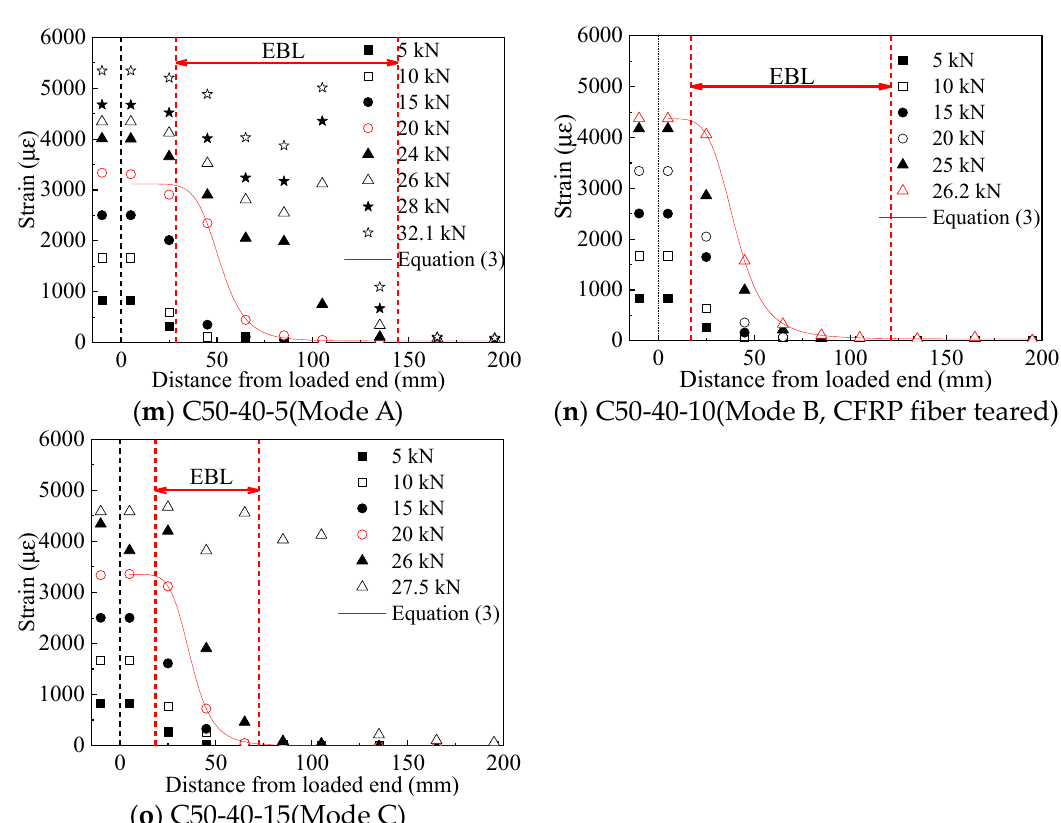
Figure 6. Strain distribution along the bond length of specimens ( a ) C30-20-0 with failure mode A; ( b ) C30-20-5 with failure mode B); ( c ) C30-20-7 with failure mode A; ( d ) C30-20-10 with failure mode A; ( e ) C30-20-15 with failure mode C; ( f ) C30-40-3 with failure mode A; ( g ) C30-40-5 with failure mode A; ( h ) C30-40-7 with failure Mode B; ( i ) C30-40-10with failure mode C; ( j ) C30-40-15 with failure mode C; ( k ) C50-40-0 with failure mode A; ( l ) C50-40-3 with failure mode A; ( m ) C50-40-5 with failure mode A; ( n ) C50-40-10 with failure mode B; ( o ) C50-40-15 with failure mode